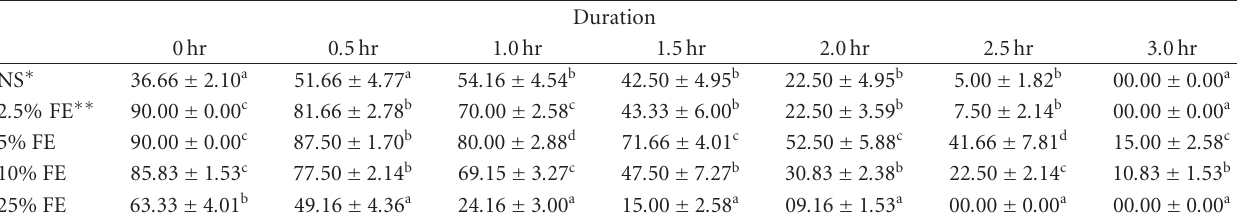
Table 2: E ff ect of foam extract on sperm motility (percentage of motile sperm) at di ff erent time intervals at room temperature (mean ± S.E.M., n =